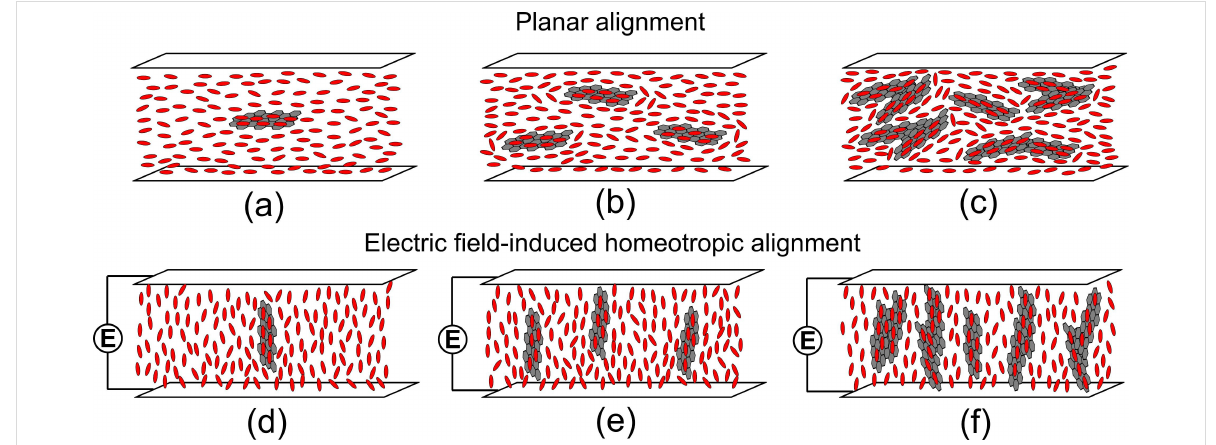
Figure 8: Liquid crystal cell filled with graphene oxide (GO) flakes suspended in a thermotropic nematic liquid crystal. The picture presents the nematic order in a planar oriented cell at (a) low, (b) medium, and (c) high concentrations of GO flakes and an electric-field-induced homeotropic alignment in the NLC-GO composite of (d) low, (e) medium, and (f) high